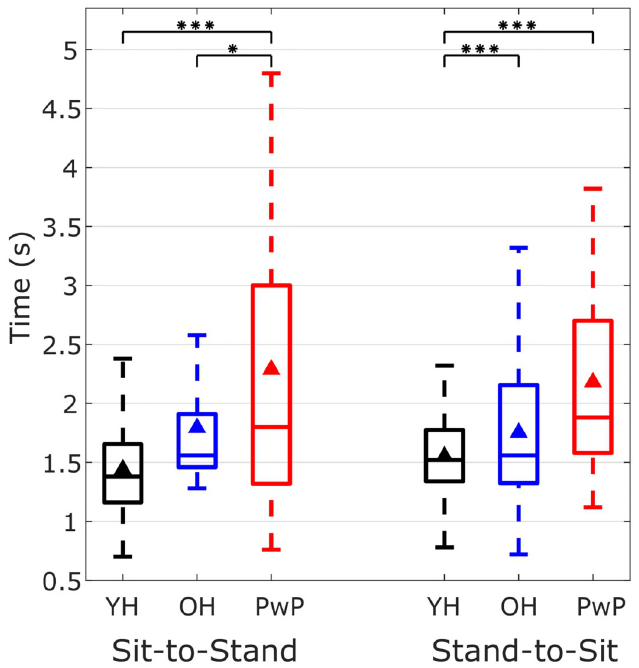
Fig 9. Timings of sit-to-stand and stand-to-sit in younger healthy (YH) adults, older healthy (OH) adults and people with Parkinsons (PwP). The time taken by participants to perform sit-to-stand and stand-to-sit from all the three YH, OH and PwP groups. The black triangle shows the mean time. Statistically significant differences (Mann- Whitney U test with Bonferroni correction for multiple tests) in the timings among the three groups for sit-to-stand and stand-to-sit are shown by the stars indicting the p-values (one star indicates p < 0.5, two stars indicate p < 0.01 and three stars indicate p < 0.001).